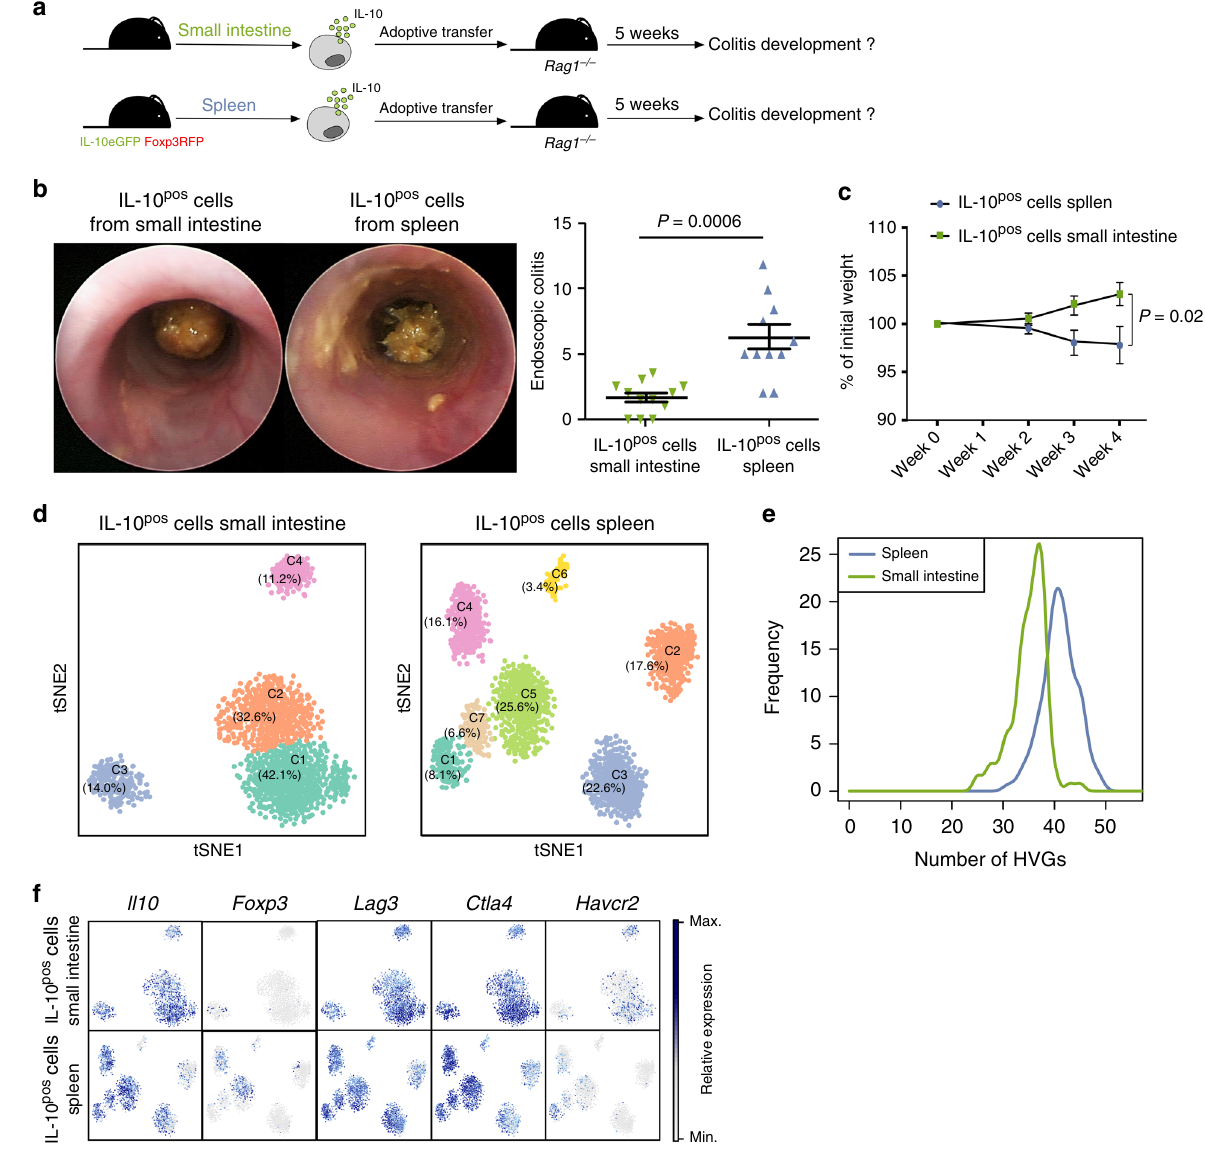
Fig. 1 Mouse IL-10-producing CD4 + T cells are heterogeneous. a – c IL-10-producing Foxp3 neg CD4 + T cells (IL-10 pos ) were isolated from small intestine or spleen of aCD3-treated IL-10 eGFP Foxp3 mRFP double reporter mice. Cells were transferred into lymphopenic hosts and colitis development was assessed by weight loss ( c ) and endoscopic colitis score ( b ) 5 weeks upon transfer (IL-10 pos cells small intestine n = 12; IL-10 pos cells Spleen n = 11; lines indicate mean ±SEM). Results are cumulative of three independent experiments. A Mann – Whitney U test was used to calculate signi fi cance. d t- SNE analysis of single cell RNA sequencing of IL-10 pos cells (including Foxp3 + cells) isolated from small intestine or spleen of aCD3-treated IL-10 eGFP Foxp3 mRFP double